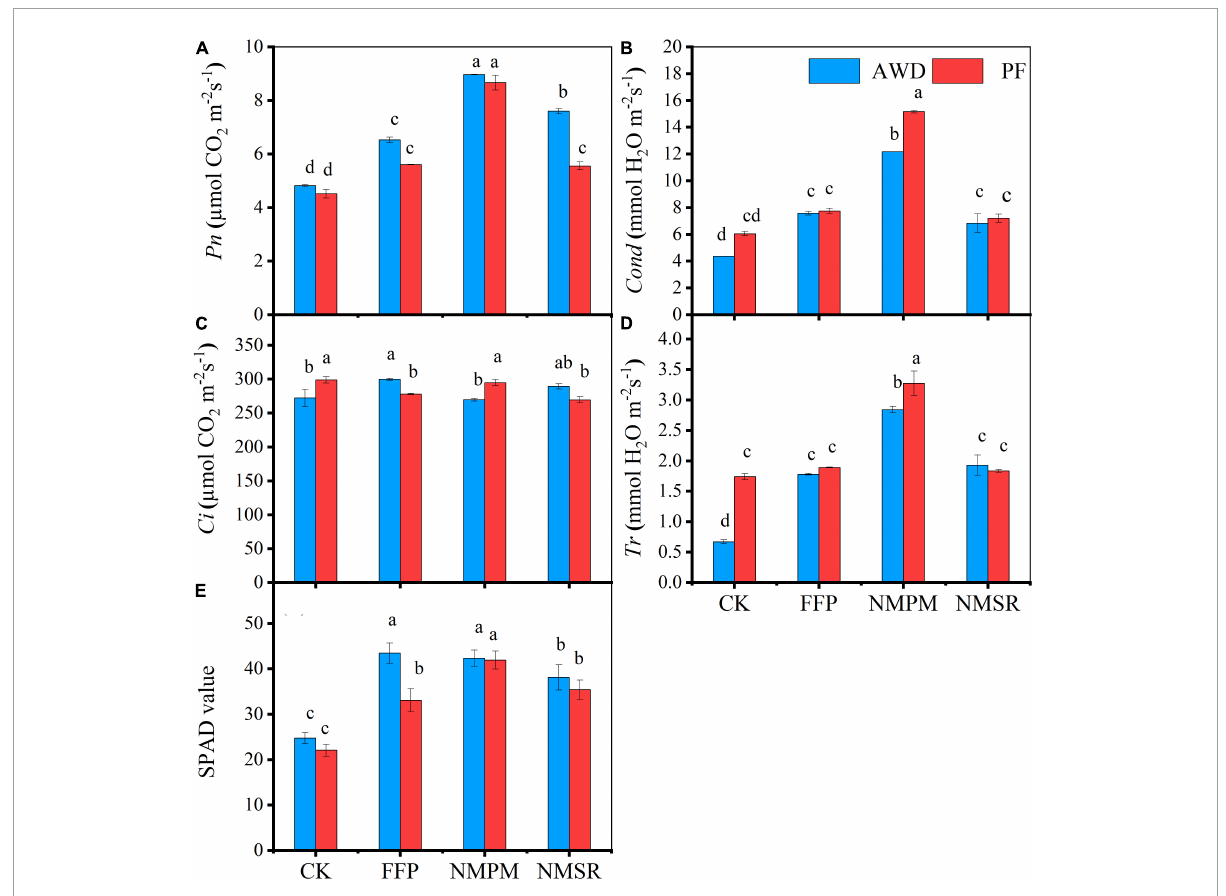
FIGURE4 Combined effect of different fertilizer treatments and water level, alternate wetting and drying (AWD), and permanent flooding (PF) on photosynthetic parameters: (A) net photosynthesis rate, (B) stomatal conductance, (C) intercellular CO 2 , (D) transpiration rate, and (E) relative chlorophyll contents (photosynthetic SPAD values). The different letters show significant difference, while the same letters represent no significant differences among the treatments while arrow bars above the lines show standard error. * Pn ; net photosynthesis rate, Cond ; stomatal conductance, Ci ; intercellular CO 2 , Tr ; transpiration rate, SPAD; soil plant analysis